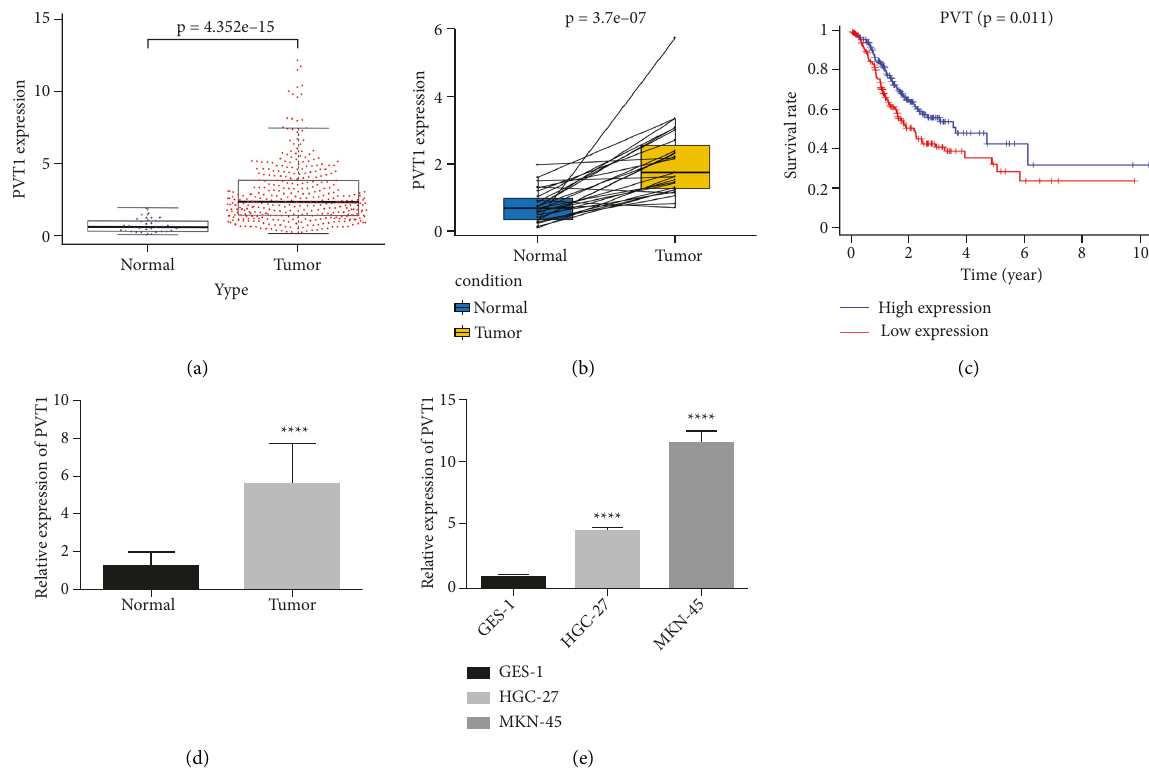
Figure 1: PVT1 is upregulated in GC tissues and cells. (a, b) The expression of PVT1 was analyzed using data from TCGA, and PVT1 was found to be upregulated in GC tissues. (c) Patient survival analyzed using data from TCGA, showing that the higher the expression of PVT1 is, the worse the prognosis is. (d) Expression of PVT1 in GC and adjacent normal tissues of 20 GC patients detected by RT-qPCR, showing that PVT1 was upregulated in GC tissues. (e) The expression of PVT1 detected by RT-qPCR in GES-1, HGC-27, and MKN-45 cell lines, showing that PVT1 was highest in MKN-45